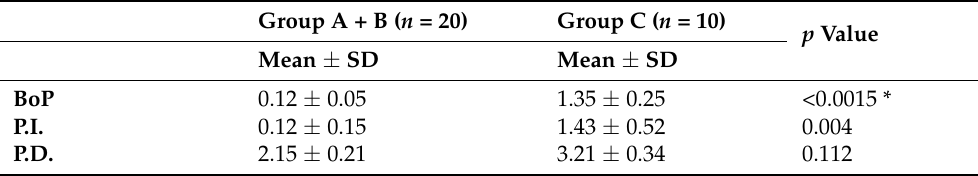
Table 2. Periodontal and microbial parameters among the A + B groups and C group after treatment. Group A + B ( n =